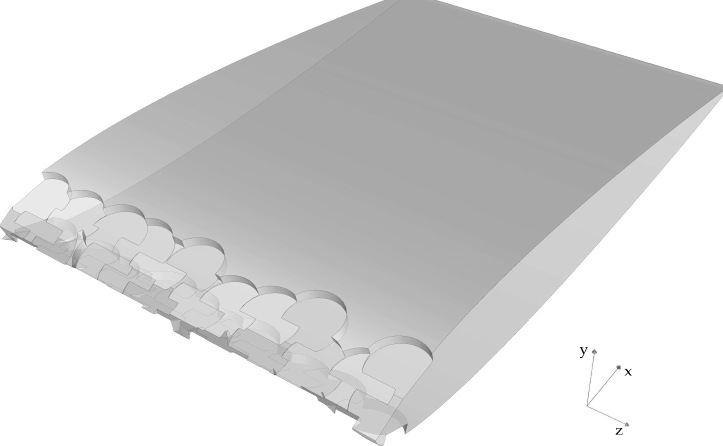
Figure 2. Geometrical representation of the three-dimensional blade with